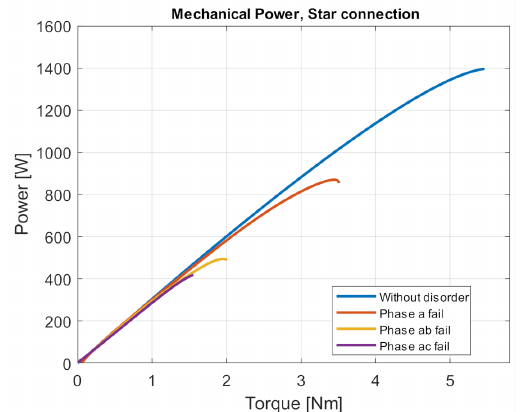
Figure 11. Power on the shaft from the load moment, star connection, U IN = 5 × 230 V, 50